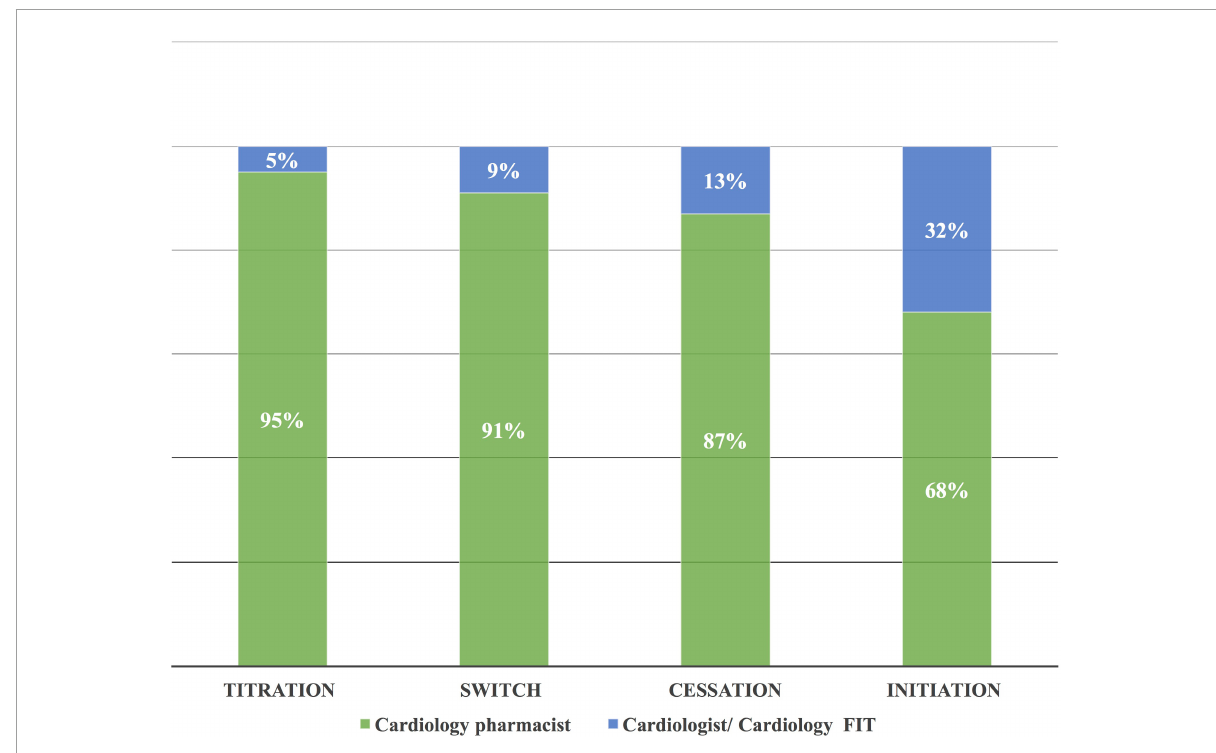
FIGURE4 Complementary drug interventions according to the main types of interventions. The cardiology pharmacist performed most of the drug interventions due to her initial interventional complementary role in the heart team with the cardiologist/FIT. FIT, fellow in